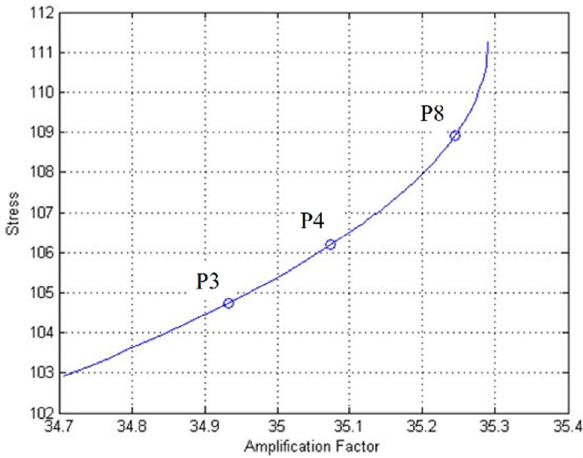
Fig. 13 Combined output points on the optimal